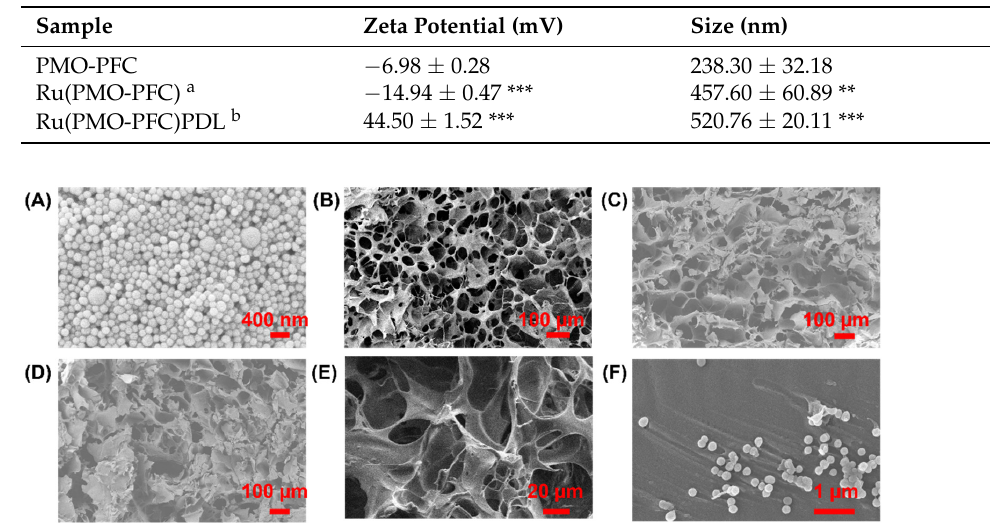
Figure 1. SEM images of PMO ‐ PFCs ( A ), G+PMO ‐ PFC ( B ), G+Ru(PMO ‐ PFC) ( C ), G+Ru(PMO ‐ PFC)PDL ( D ), zoom ‐ in image of hydrogel ( E ) and PMO ‐ PFCs inside the hydrogel network ( F ).